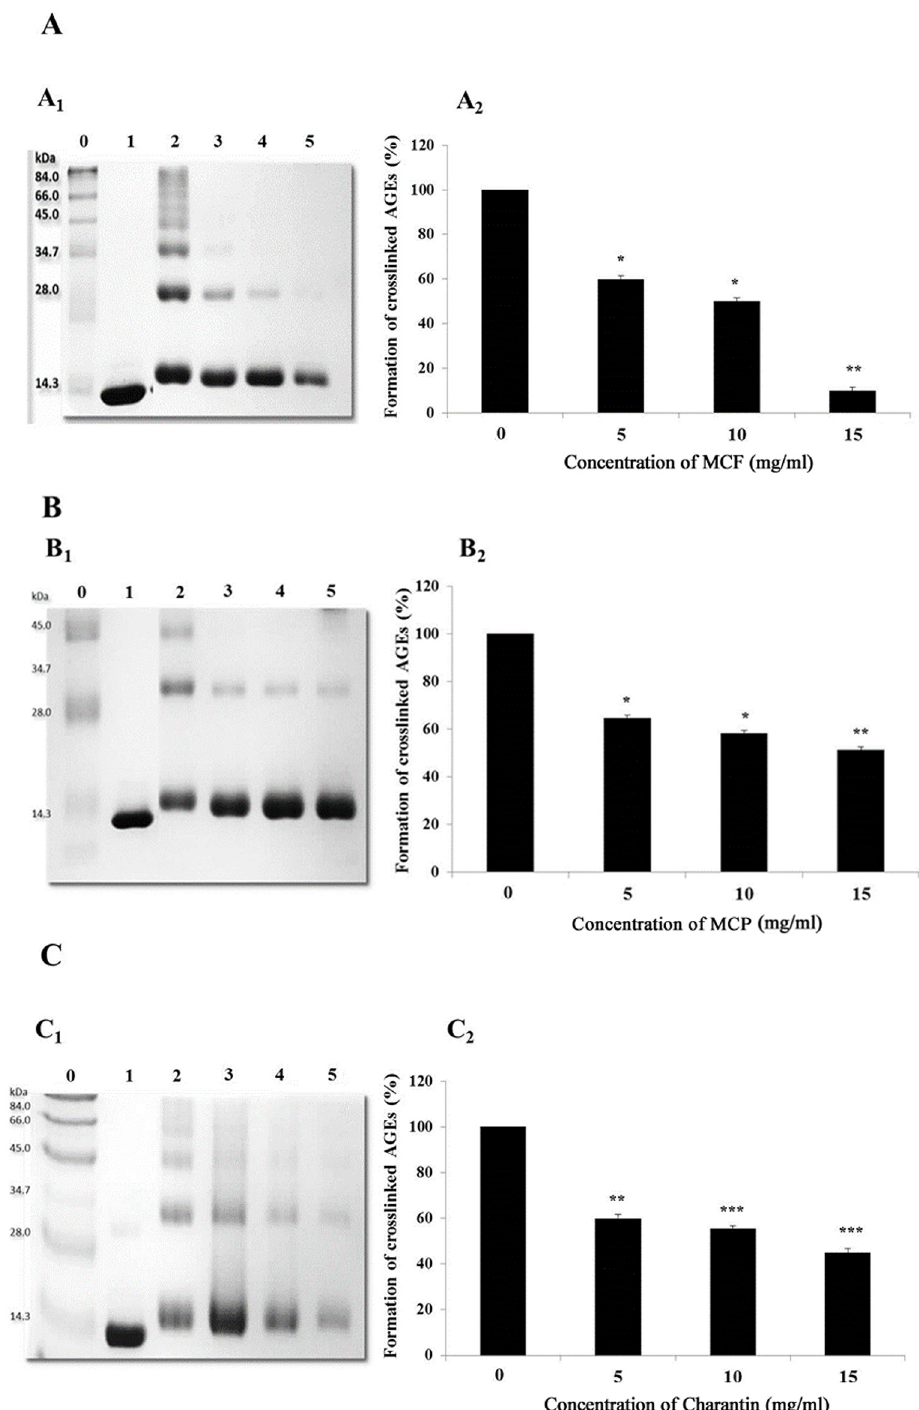
Fig 1. Effects of different concentrations of MCF (A), MCP (B) and charantin (C) on the formation of crosslinked AGEs. A representative SDS-PAGE gel showing lysozyme (10 mg/ml) incubated alone (lane 1) or in the presence of 0.1 M methylglyoxal (lane 2) in 0.1 M sodium phosphate buffer of pH 7.4 for 3 days at 37°C. The dimer formation resulting from protein crosslinking was determined using different concentrations of the MCF (A 1 ) and MCP (B 1 ) extracts or charantin (C 1 ): 5 mg/ml (lane 3), 10 mg/ml (lane 4) and 15 mg/ml (lane 5). Lane 0 contains the marker proteins. The bar charts show the effects of different concentrations